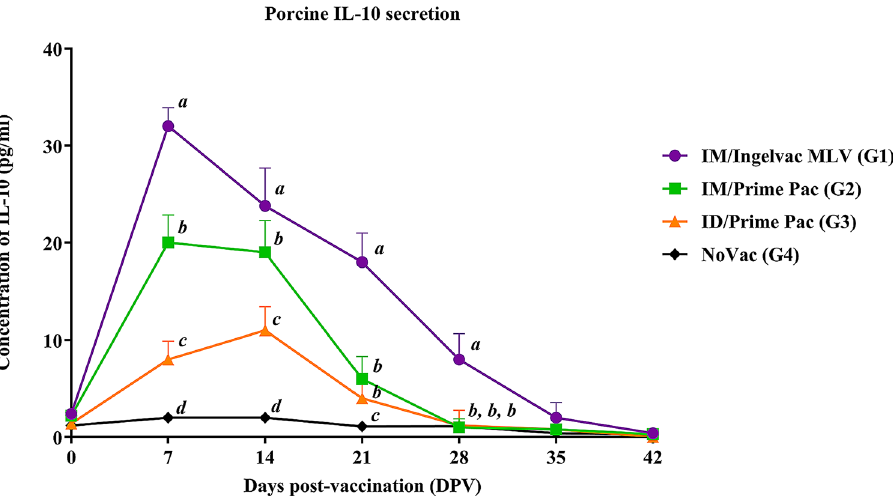
Figure 2. Quantification of porcine IL-10 secretion in stimulated PBMC with homologous viruses (vaccine viruses) of pigs in Exp A. Values expressed as mean ± SEM. The results were compared using two-way ANOVA for multiple comparisons. Different lowercase letters ( a – d ) indicate significant differences between treatment groups ( P < 0.05) for each time-point.